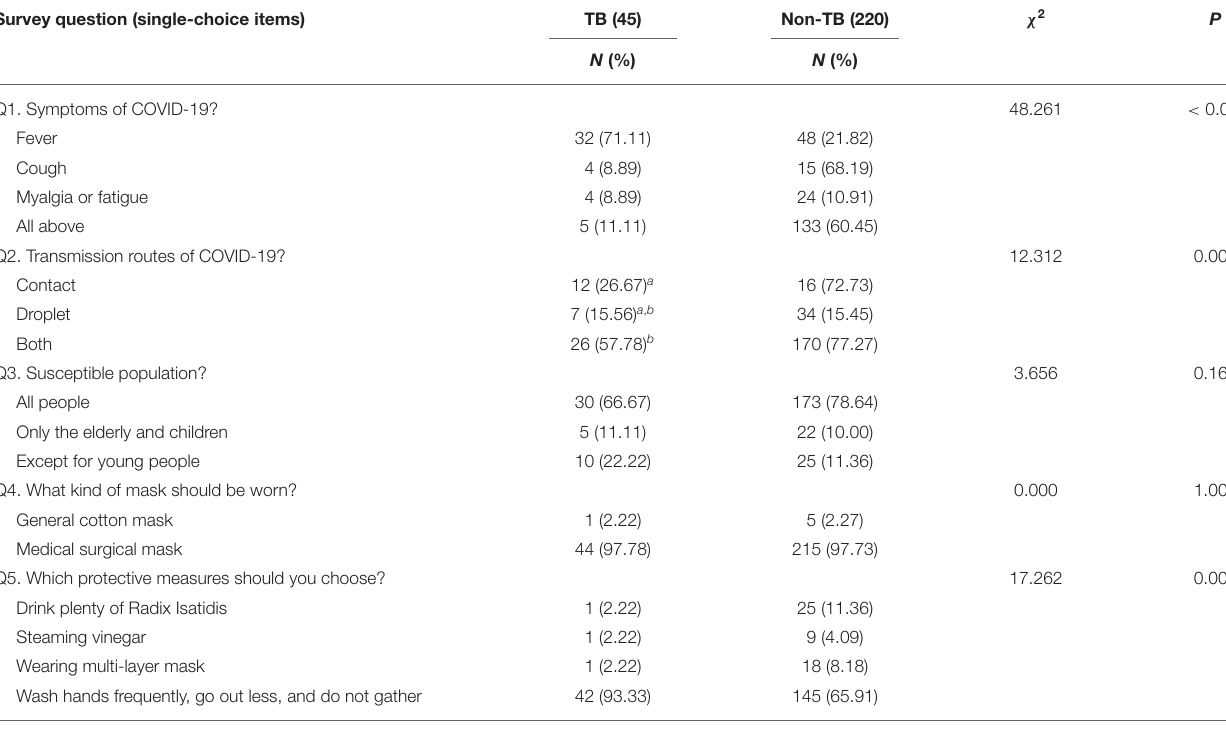
TABLE 2 | COVID-19 awareness results.